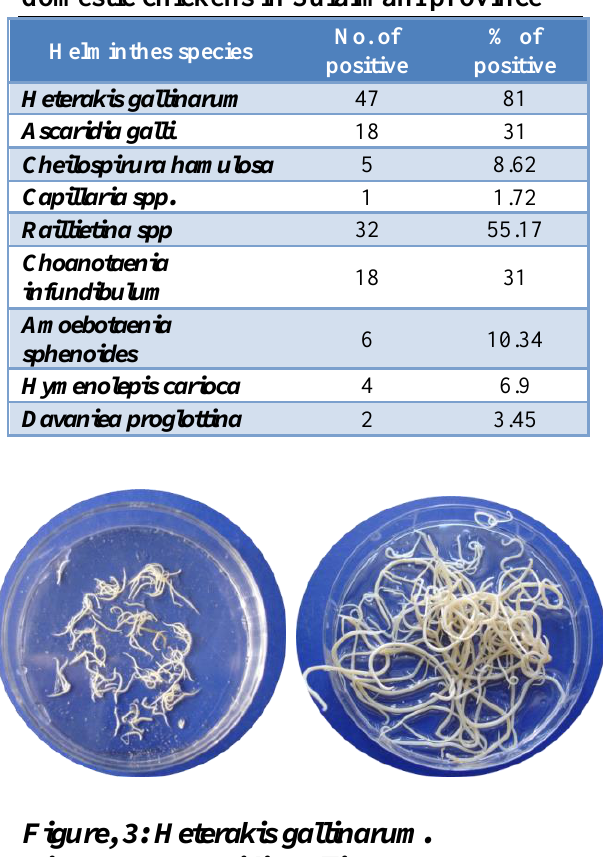
Figure, 3: Heterakis gallinarum. Figure, 4: Ascaridia galli.